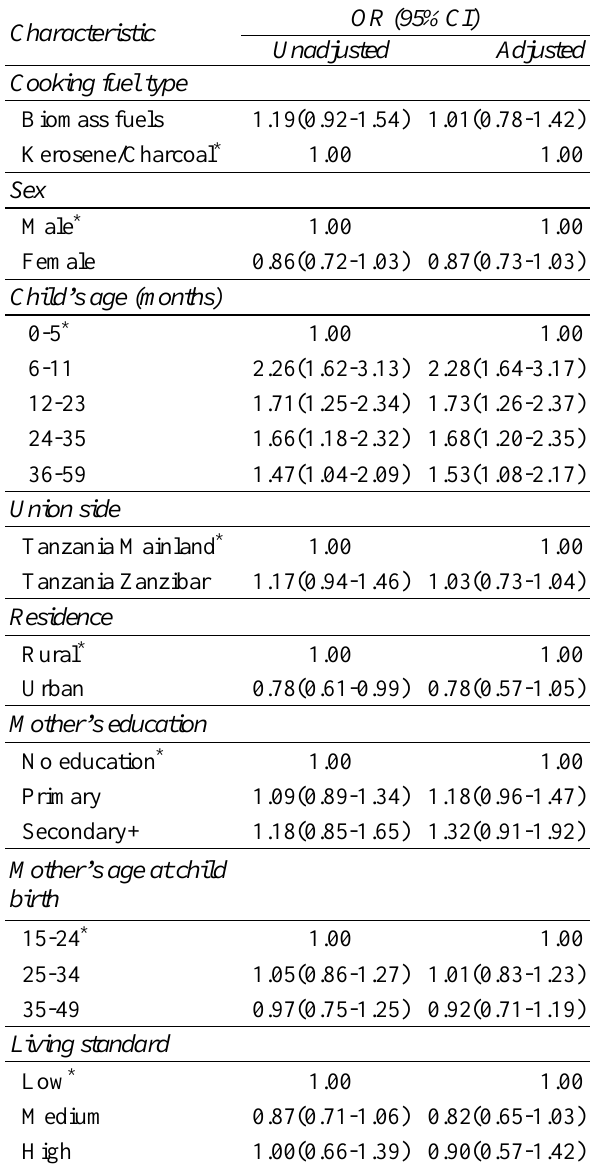
Table 2 : Odds ratio estimates of effects of fuels used for cooking on ARI prevalence in